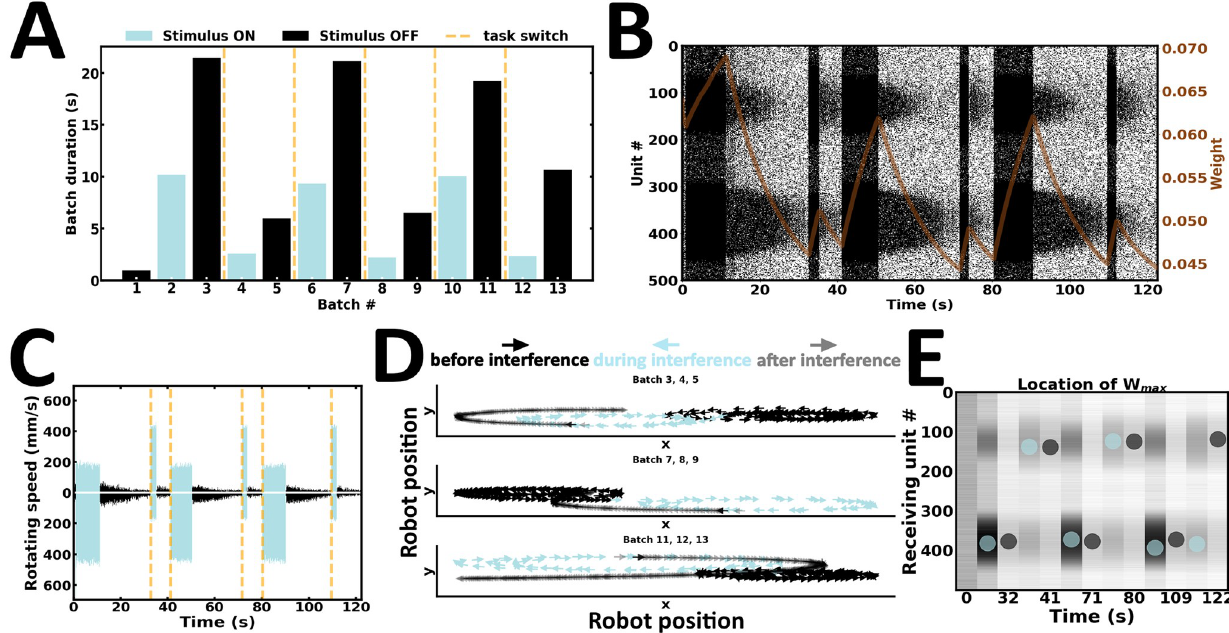
Fig 12. Submitting to interfering inputs. (A) Duration of alternating batches of evoked and spontaneous activity. (B) Raster plot of network activity. Interfering inputs disrupt cue-guided patterns of local persistent activity; brown curve, average synaptic efficacy. (C) Rotating speed of left and right wheel motors as a function of time. (D) Motor trajectory of the robot before, during and after the presentation of interfering inputs. (E) Spatial location of the highest average incoming synaptic weights; blue and black dot, evoked and spontaneous activity,